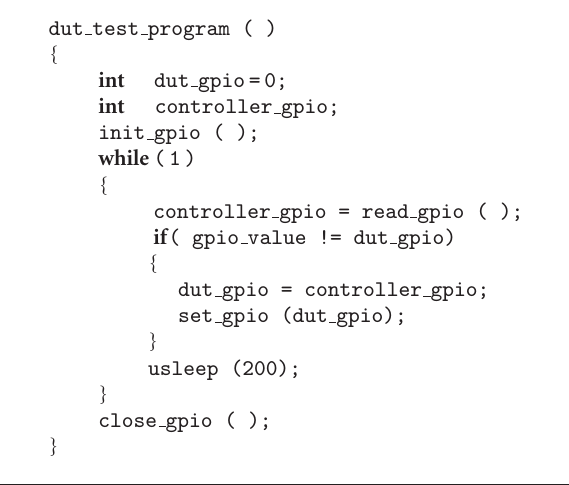
Table 1: Time breakout of a nonsensitive bit